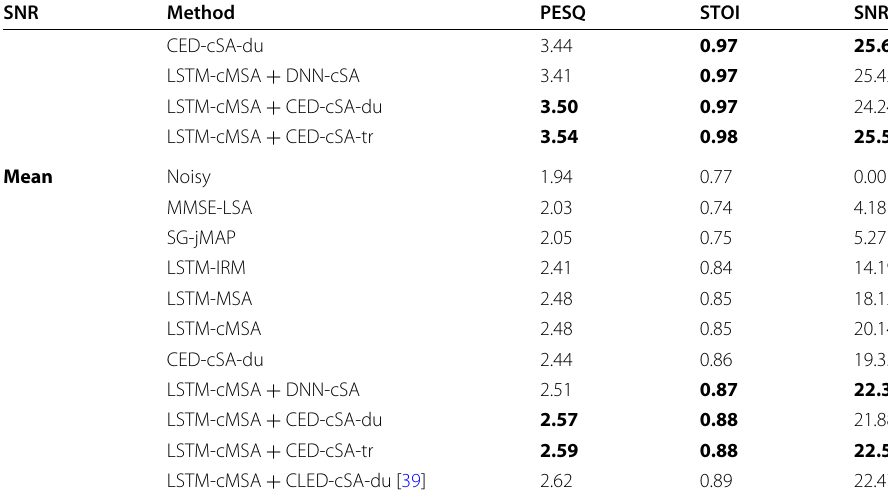
Table 3 Instrumental measures for baseline and proposed approaches averaged over unseen noise types of the test set data. Note that the SNR conditions of − 5 and 15 dB are unseen during training, whereas the remaining SNRs have been seen. Best two approaches are in boldface , high-complexity reference LSTM-cMSA+CLED-cSA-du excluded ( Continued